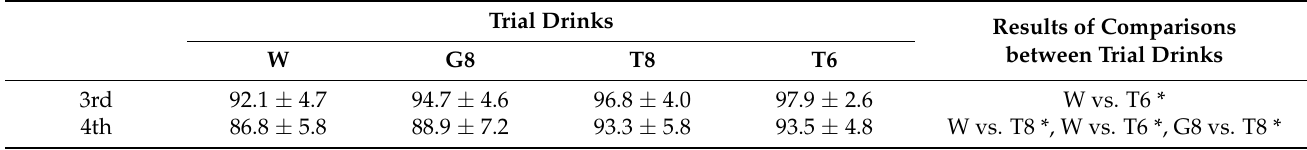
Table 2. Mean power value assessment and statistical analysis results (experiment 1).